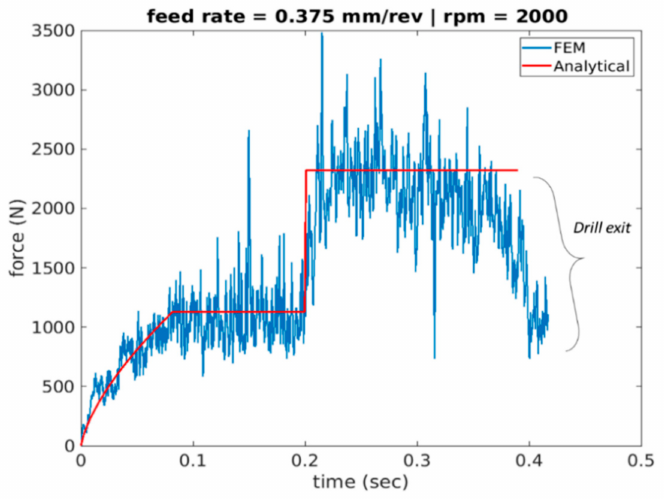
Figure 16. Force profile for scenario 5 of feed rate 0.375 mm/rev and 2000 spindle rpm (Analytical vs.